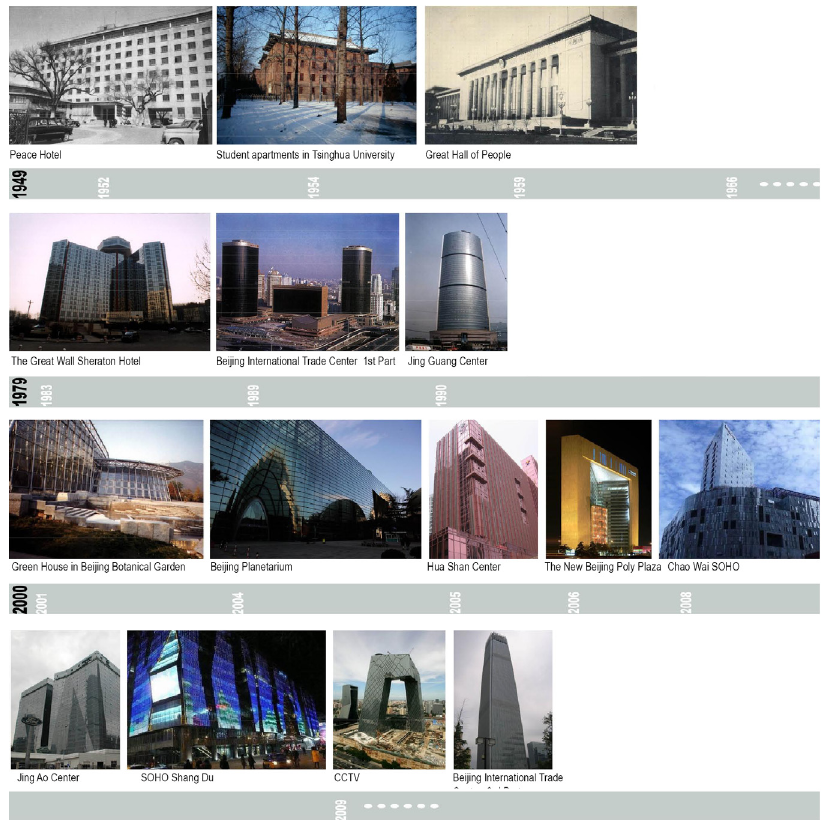
Figure 3: The diagram of glass buildings development in Beijing from 1950 to